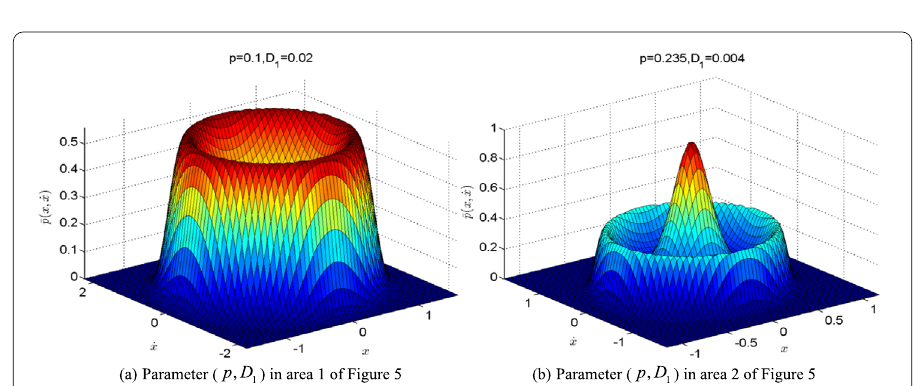
Figure 7 Joint PDFs for ¯ p ( x , ˙ x ) under additive noise excitation (taking p and D 1 as unfolding parameters)